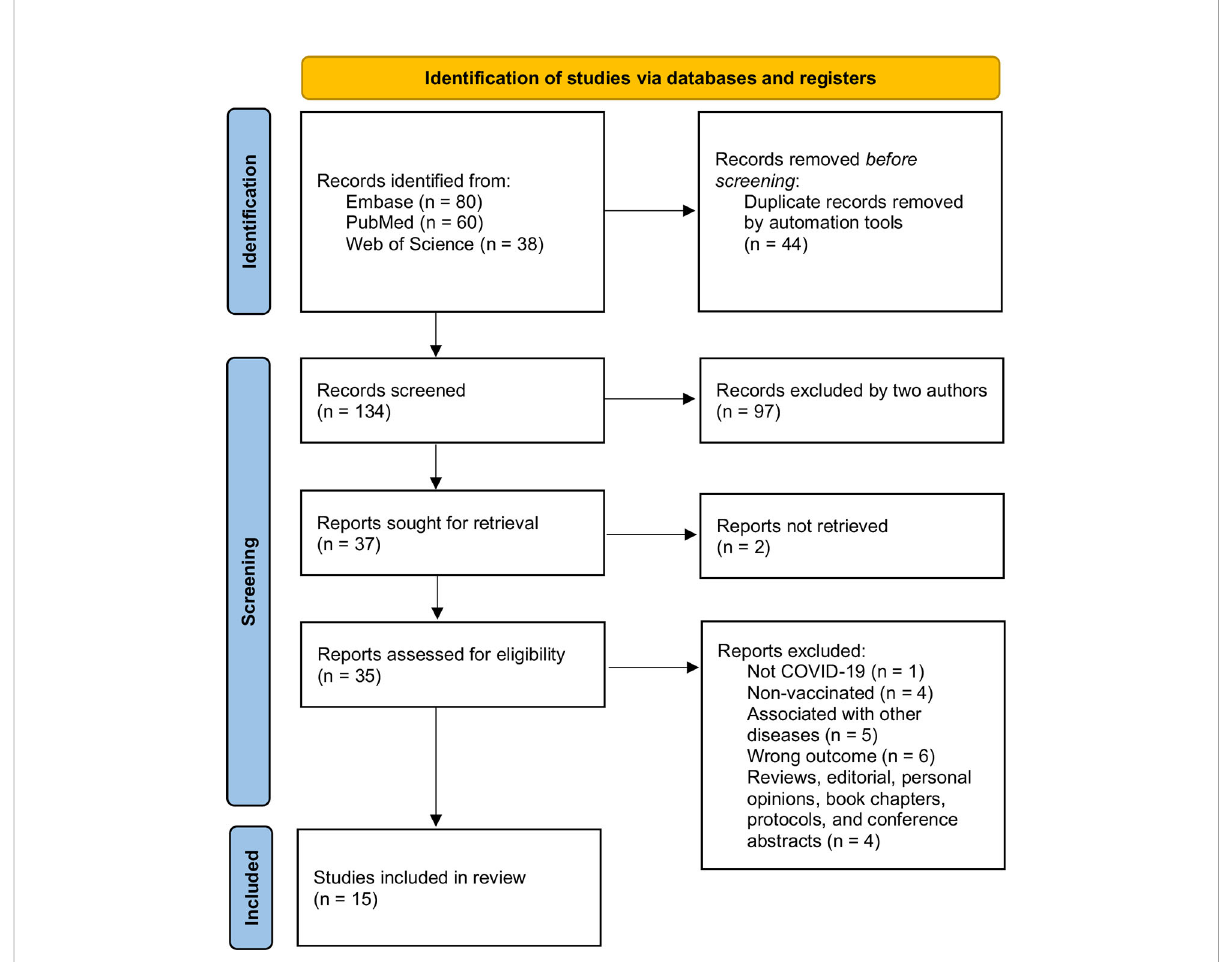
FIGURE 1 Flow diagram of literature search and selection criteria based on PRISMA